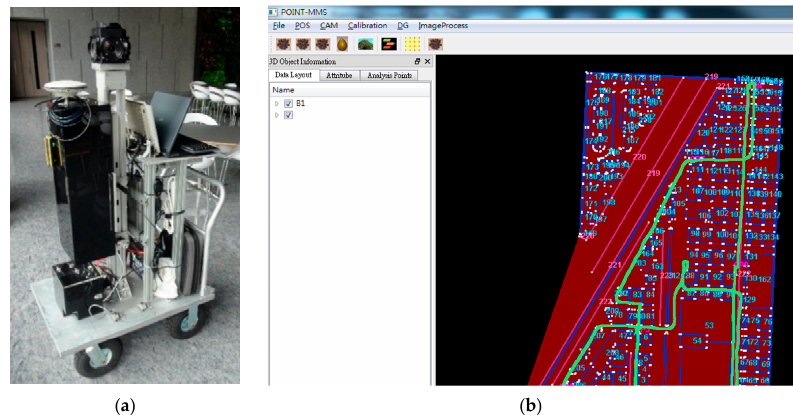
Figure 2. This figure shows the system and software for map production: ( a ) The hardware of IMMS; ( b ) The user interface of software for map production and measuring image.